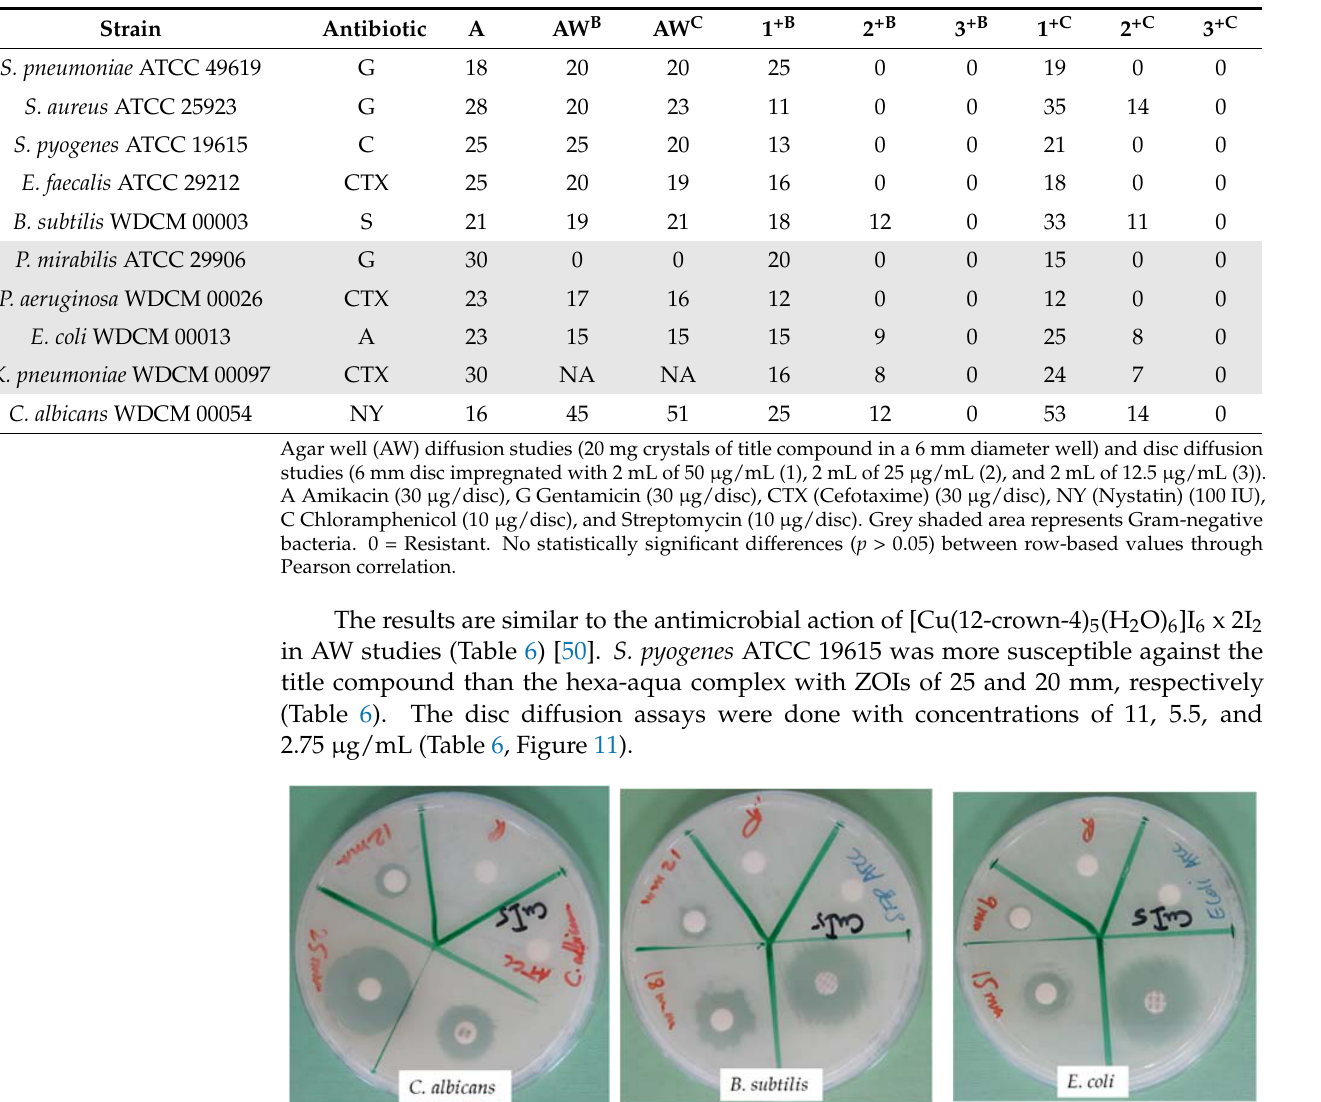
μ g/disc). Grey shaded area represents Gram ‐ negative bacteria. 0 = Resistant. No statistically signif ‐ icant differences ( p > 0.05) between row ‐ based values through Pearson correlation. Table 6. The antimicrobial testing of antibiotics (A), title compound (B), and [Cu(12-crown- 4) 5 (H 2 O) 6 ]I 6 x 2I 2 (C) [50] by Agar Well (AW) and disc dilution studies (1,2,3). The ZOI (mm) against microbial strains was determined by diffusion assay.